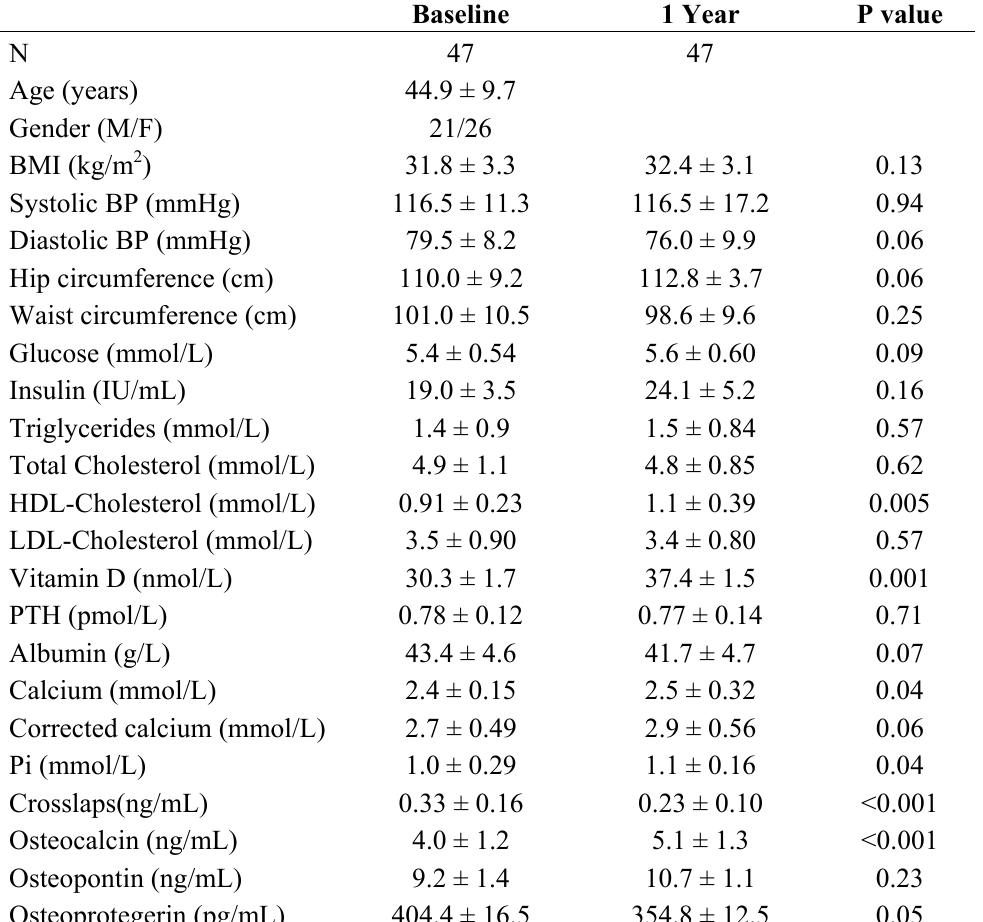
Table 1. General characteristics of subjects at baseline and 12 months post-intervention.